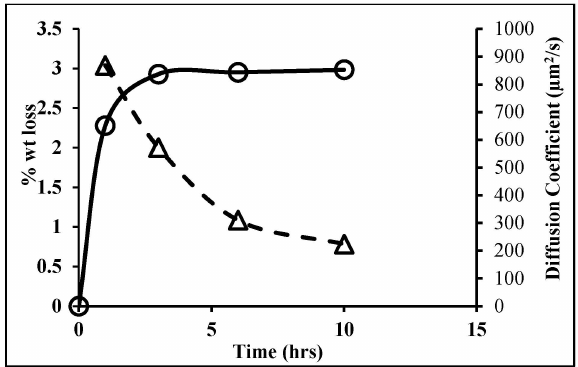
Figure 13. Percentage weight loss and diffusion coefficient of green part using Hexane at temperature of 60 ˝ C.